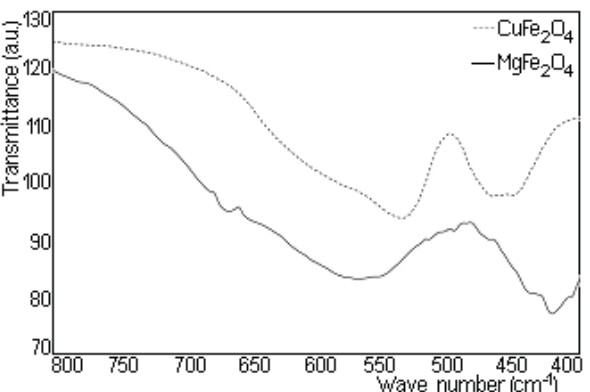
O (M II = Mg, Cu) ferrites obtained after 2 4